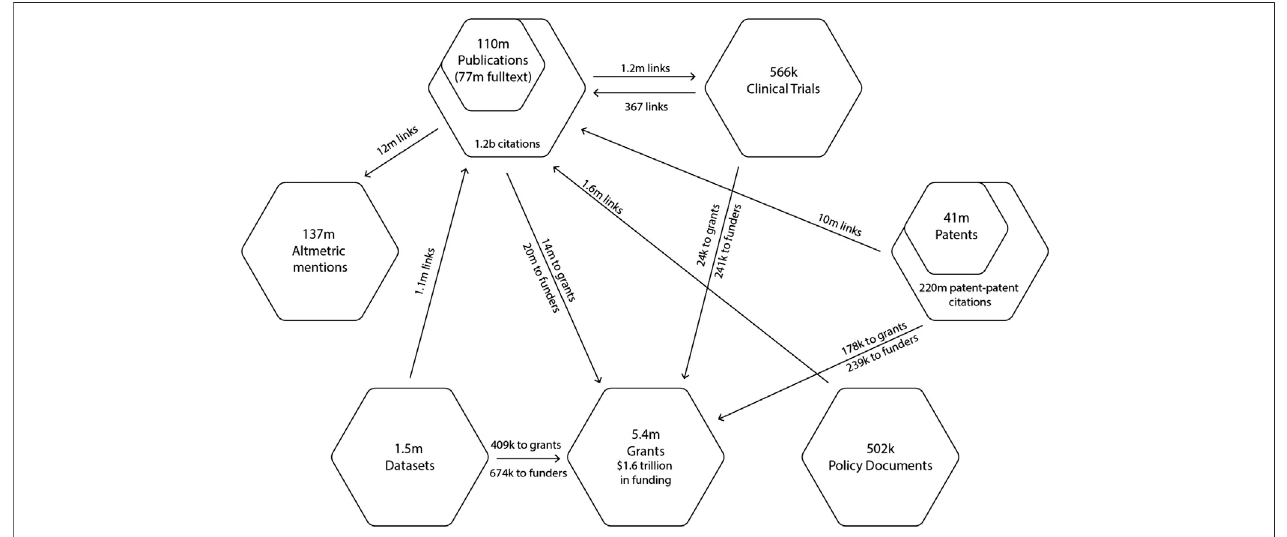
FIGURE 1 | Volume of data holdings by object type and volume relationships between objects in Dimensions as of June